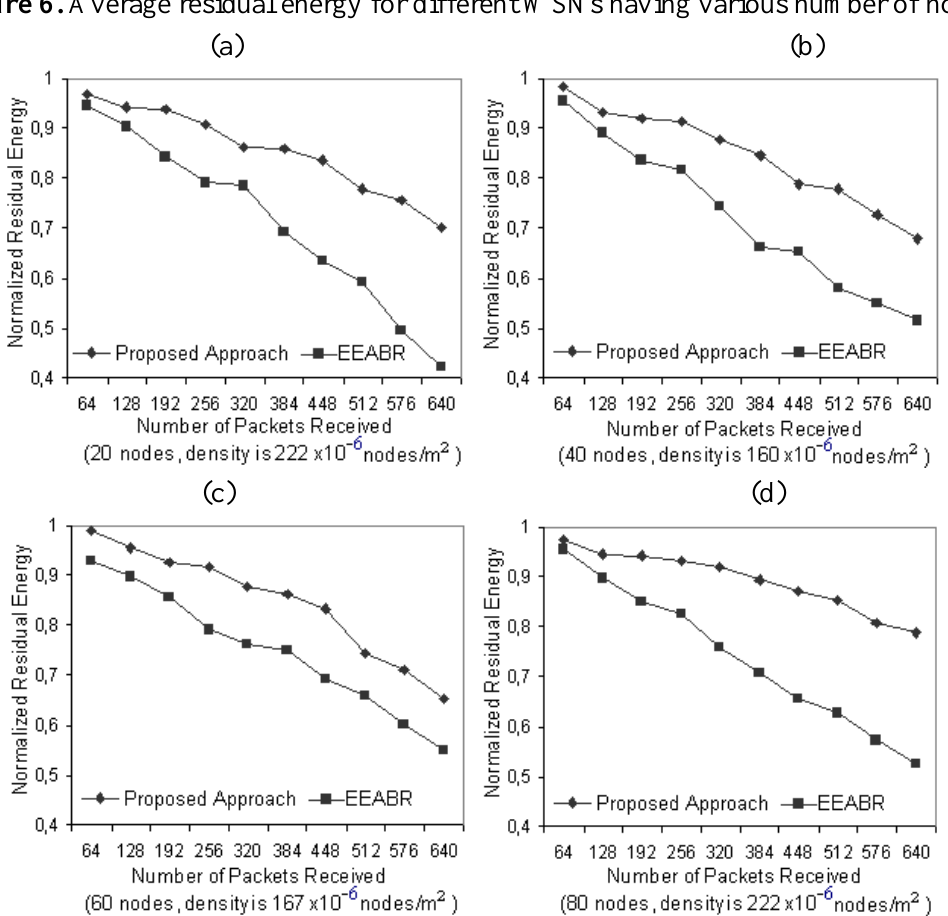
Figure 6. Average residual energy for different WSNs having various number of